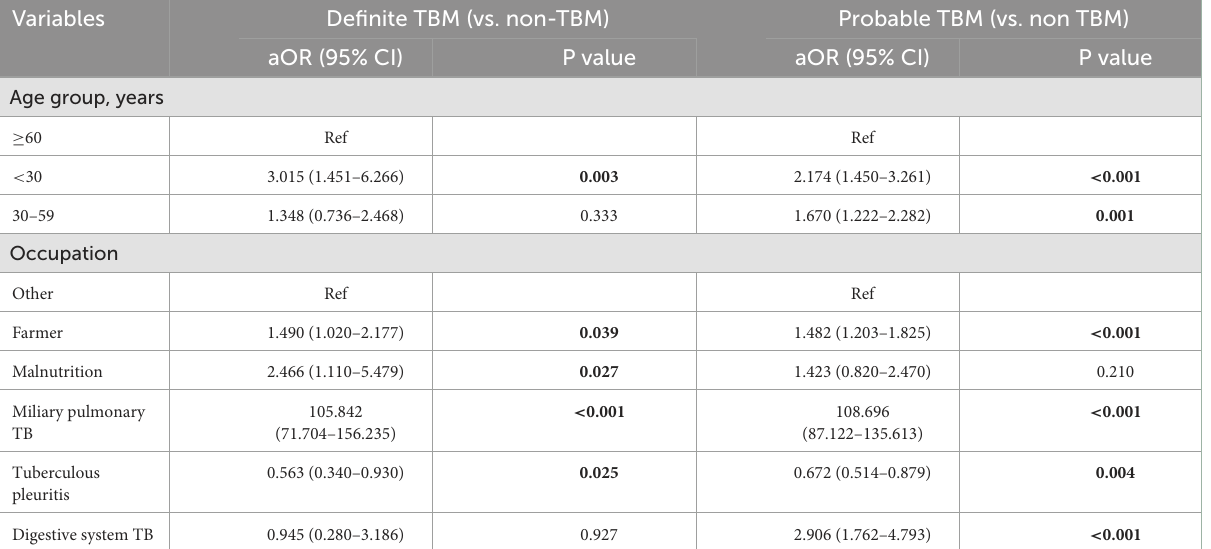
TABLE 2 Associated factors for definite TBM and probable